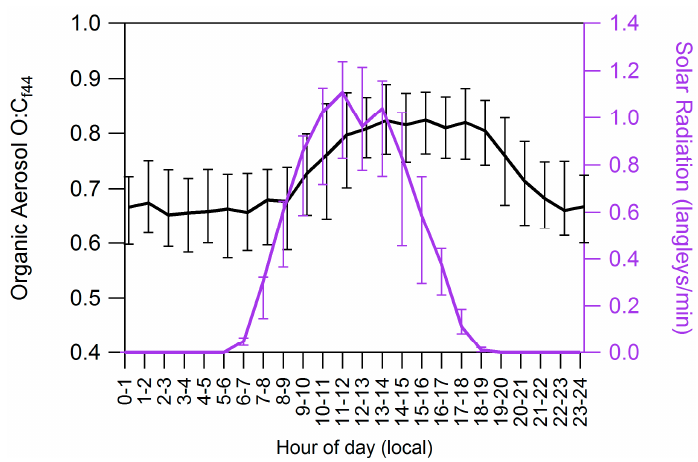
Figure 7. Diurnal cycle of organic aerosol oxygen to carbon ratio (O:C f44 ) and solar radiation. Atmosphere 2016 , 7 , 73 Some meteorological factors may play a significant role in diurnal trends. Temperature and boundary layer height (BLH) effects on concentrations of PM are explored in Figure 8. Temperature